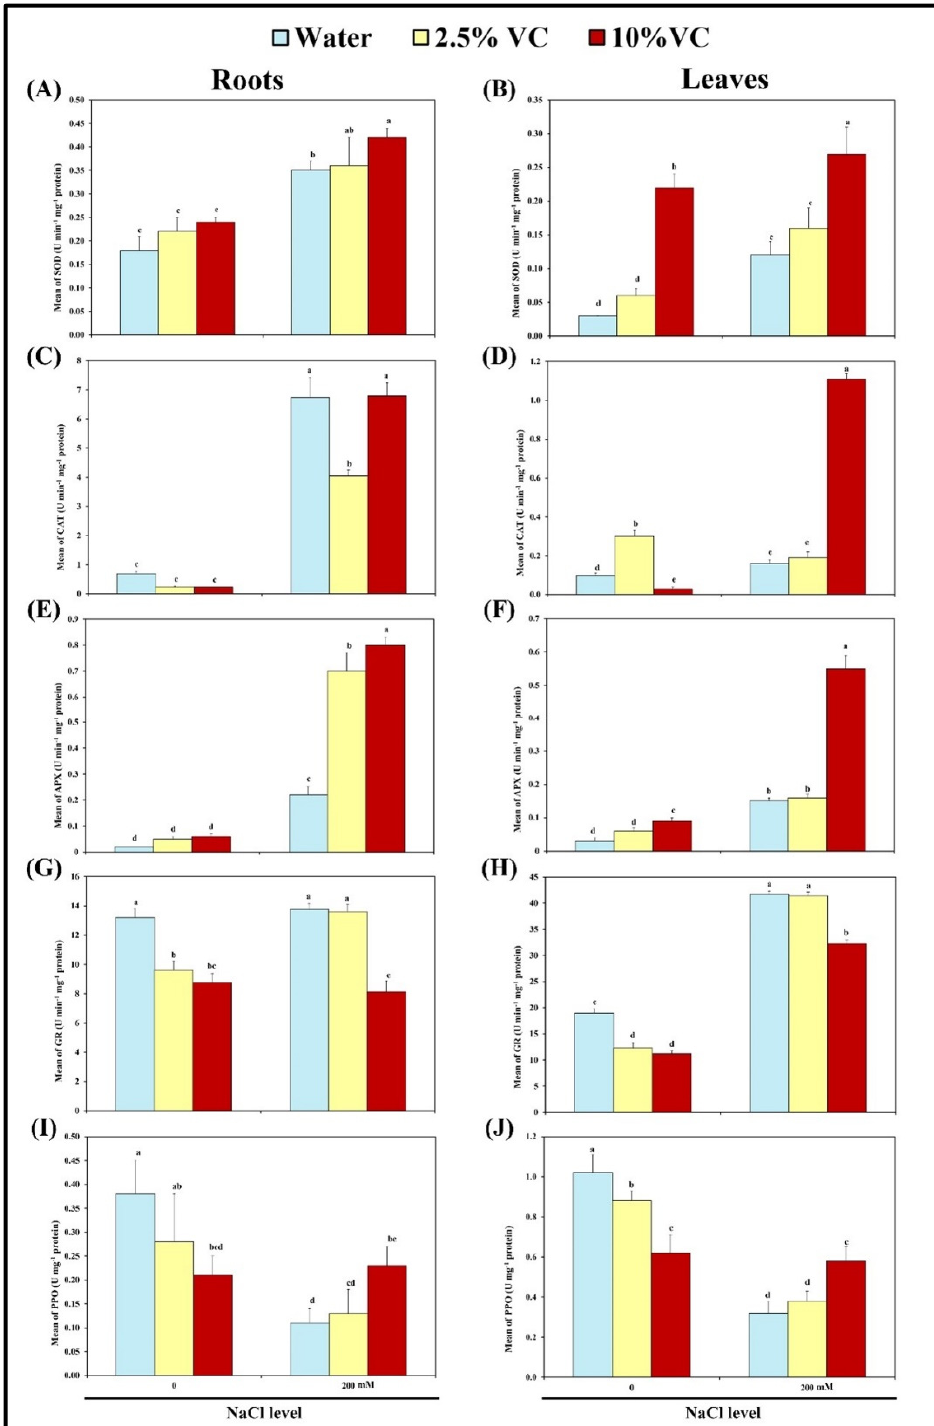
Figure 2. Effects of vermicompost with 2.5 and 10 percentages on superoxide dismutase-SOD ( A , B ), catalase-CAT ( C , D ), ascorbate peroxidase-APX ( E , F ), glutathione reductase-GR ( G , H ) and polyphenol oxidase-PPO ( I , J ) in the roots and leaves of broad bean plants exposed to 0 and 200 mM NaCl after 30 days of cultivation. Bars represent means and standard deviation of three independent replications ( n = 3). Different alphabetical letters indicate significant differences among the treatments at p < 0.05, according to a Duncan’s multiple range test. The activity of polyphenol oxidase (PPO) is illustrated in Figure 2I,J. Salt stress treatments resulted in a decrease in PPO activity in roots and leaves by about 71% and 69% of the control value, respectively. In contrast, PPO activity in 200 mM NaCl and